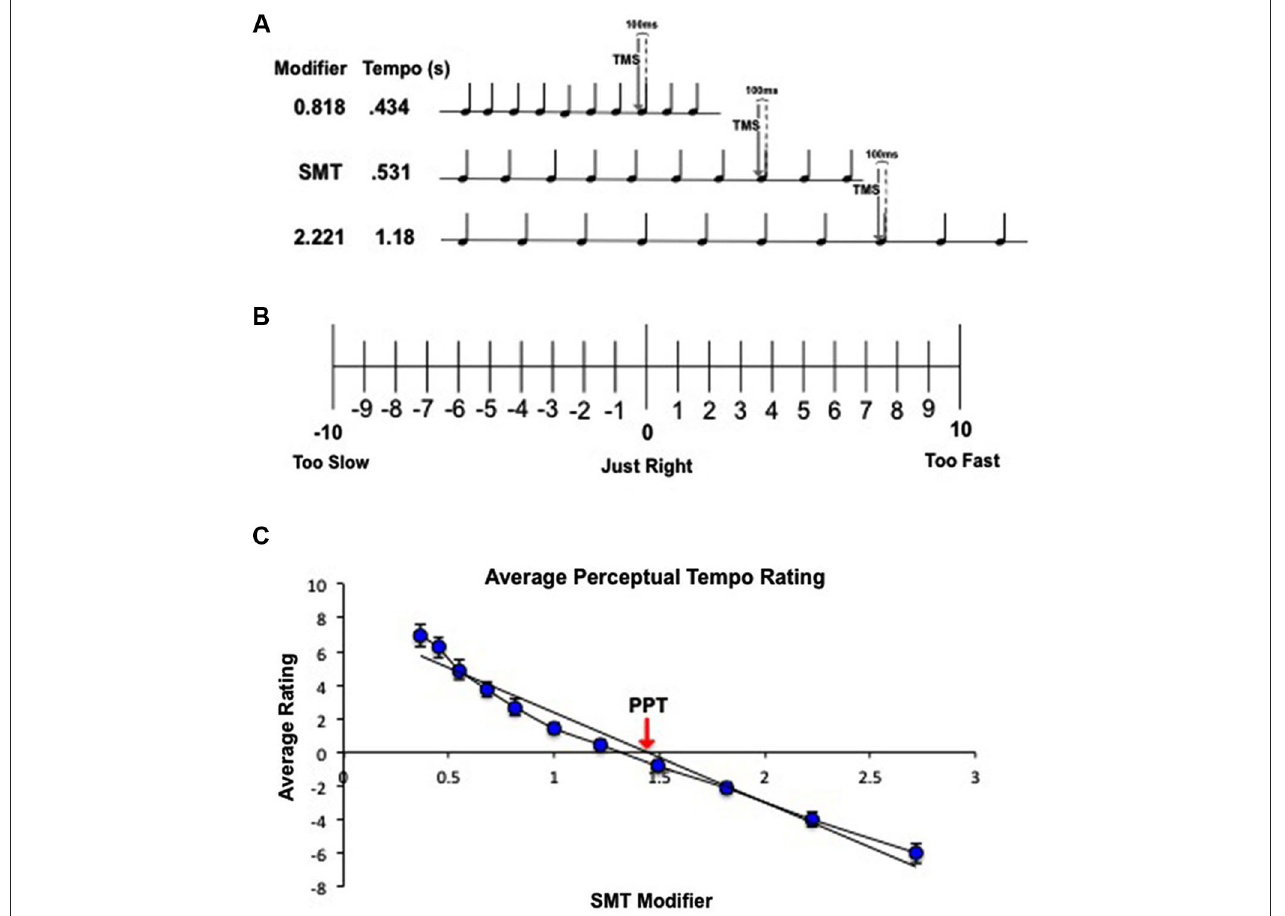
determine PPT. Subjects listened to tone sequences traveling at 11 different tempos, one at the subject’s SMT and 10 tempos spaced logarithmically above and below SMT (1 = SMT). At the end of each tone sequence, subjects rated the tempo according to how “right” the speed felt to them using the scale pictured above. (C) Calculation of PPT for a single subject. Ratings were averaged across trials and fit with a linear regression. The zero crossing indicates the subject’s